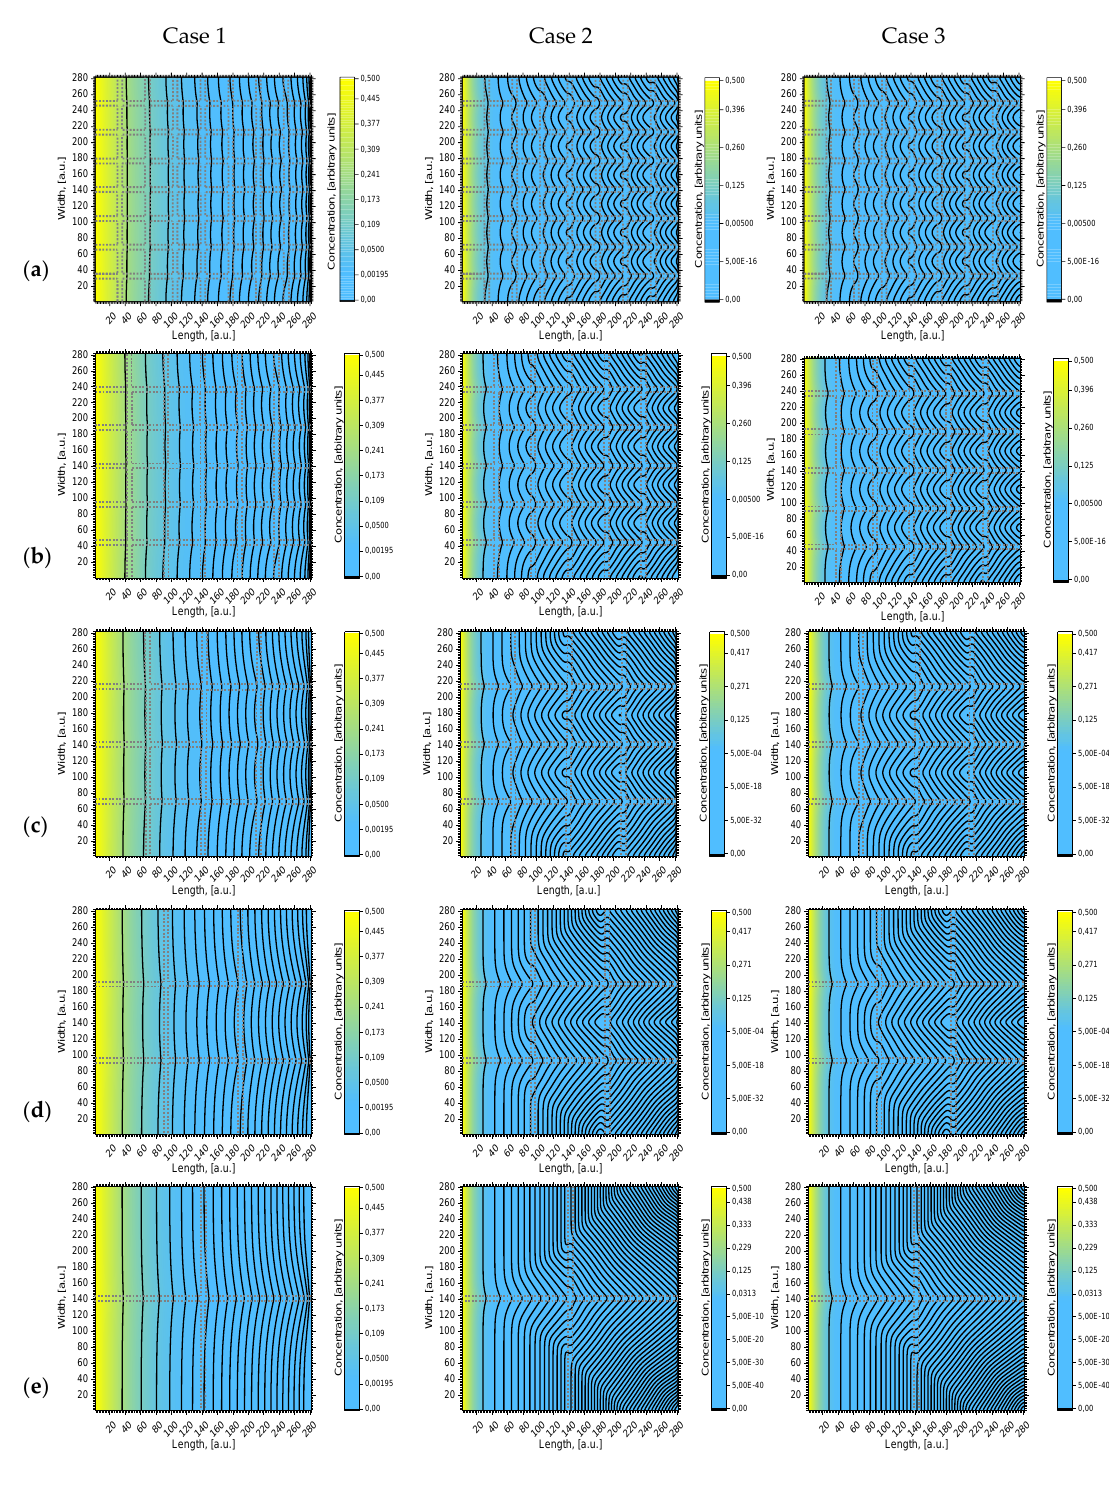
Figure 3. Calculated concentration distribution images with concentration contours of models ( a ), ( b ), ( c ), ( d ) and ( e ) (see Error! Reference source not found. 2) for Case 1, Case 2, and Case 3 (see Table 2).